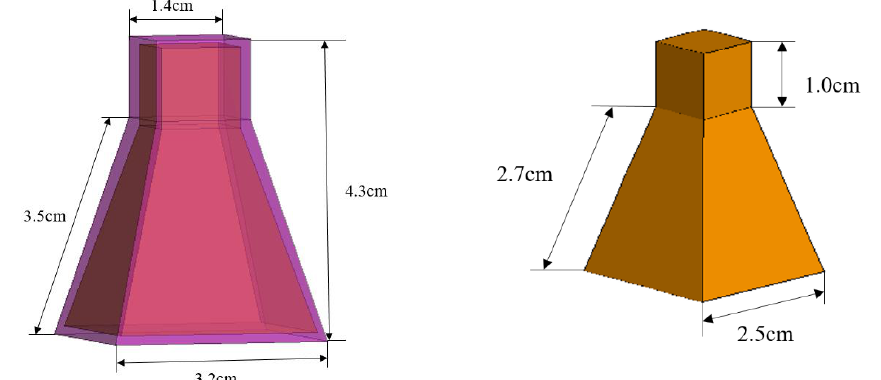
Figure 6. The geometry of the coated target.